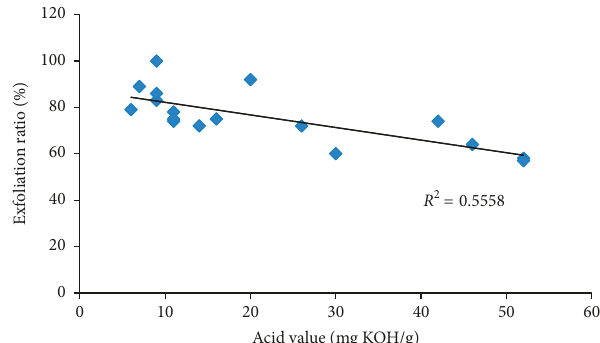
Figure 3: Nanoclay exfoliation ratio as a function of the weight fraction of polar groups in the compatibilizer.